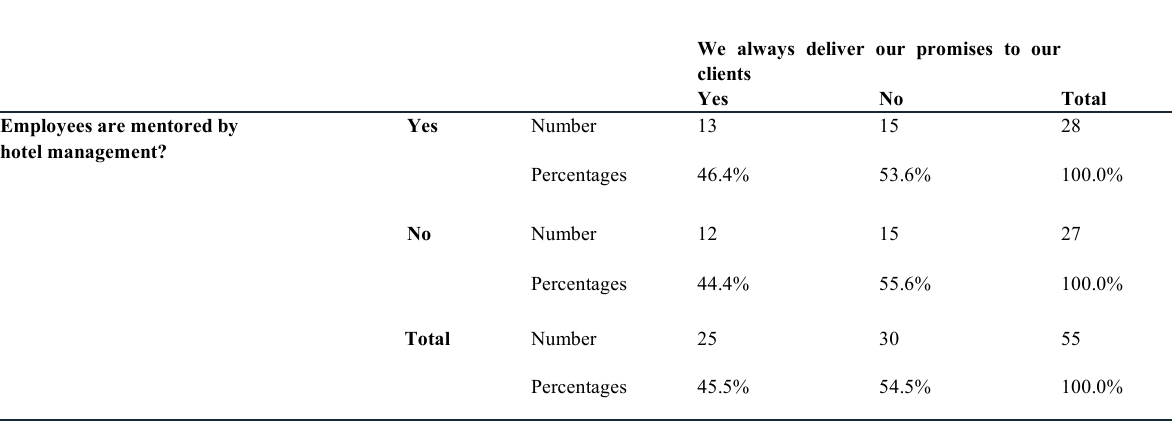
Table1: Relationship between Employee Mentorship & Coaching and